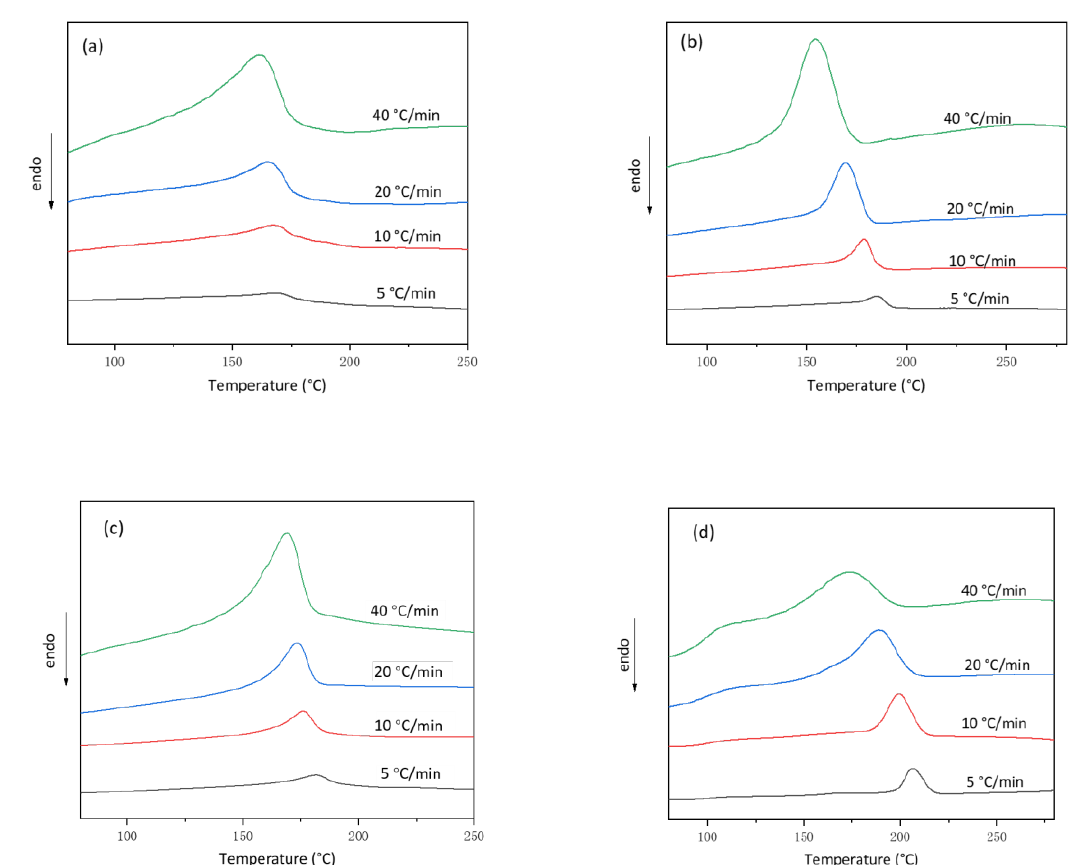
Figure 8. Cooling curves based on DSC measurements at different cooling rates: ( a ) TPAE-1000, ( b ) TPAE-1500, ( c ) TPAE- 2000 and ( d ) PA10T/10I. Table 4. DSC parameters of TPAEs and PA10T/10I at different cooling rates.